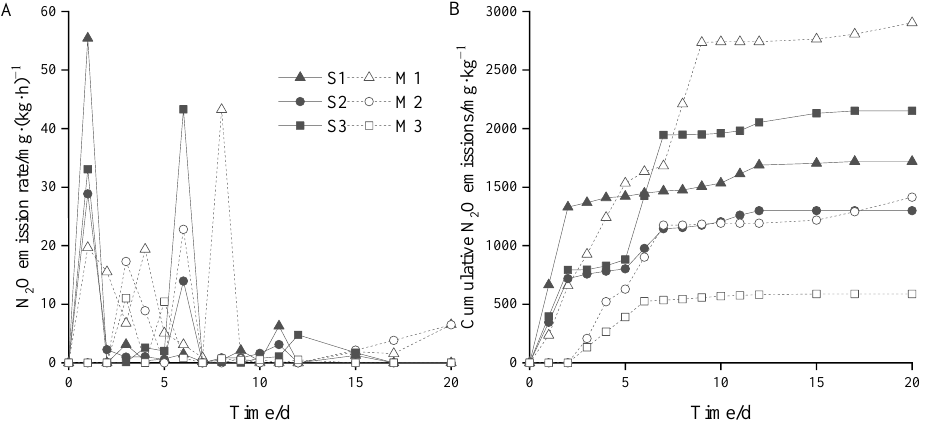
Figure 5. N 2 O emission rate(A) and cumulative N 2 O emissions(B) during composting. S1: pig manure + straw; S2: pig manure + straw + 3% SSP; S3: pig manure + straw + 6% SSP; M1: pig manure; M2: pig manure + 3% SSP; M3: pig manure + 6% SSP.